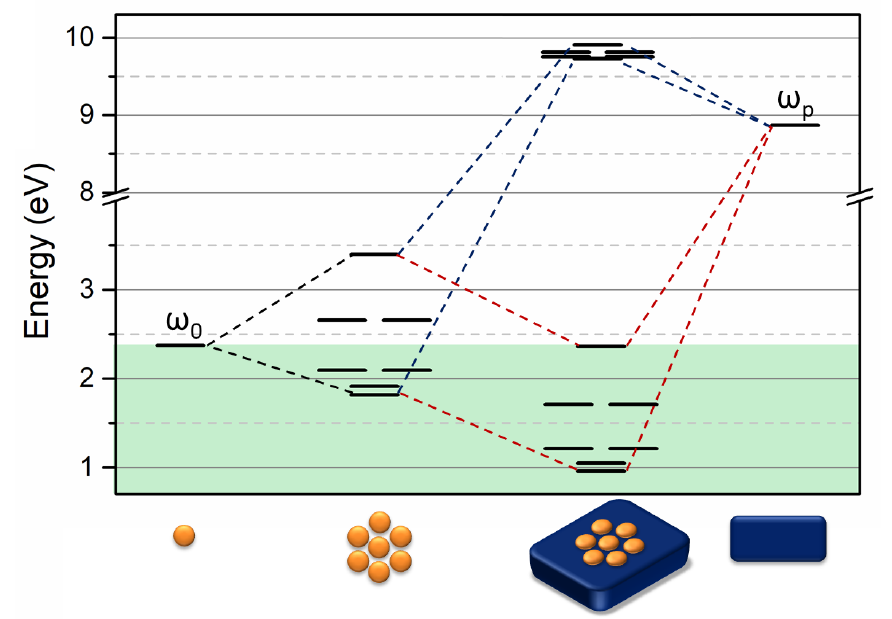
Figure 11. Sketch of the linear combination in the Variational Method for the heptamer on a gold surface. The black lines symbolize modes of three different systems (from left to right): heptamer cluster, heptamer cluster on the surface, and the surface with plasmon energy ω p = 8.87 eV. The green region illustrates the position of bright mode ω < ω 0 with ω 0 = 2.38 eV.